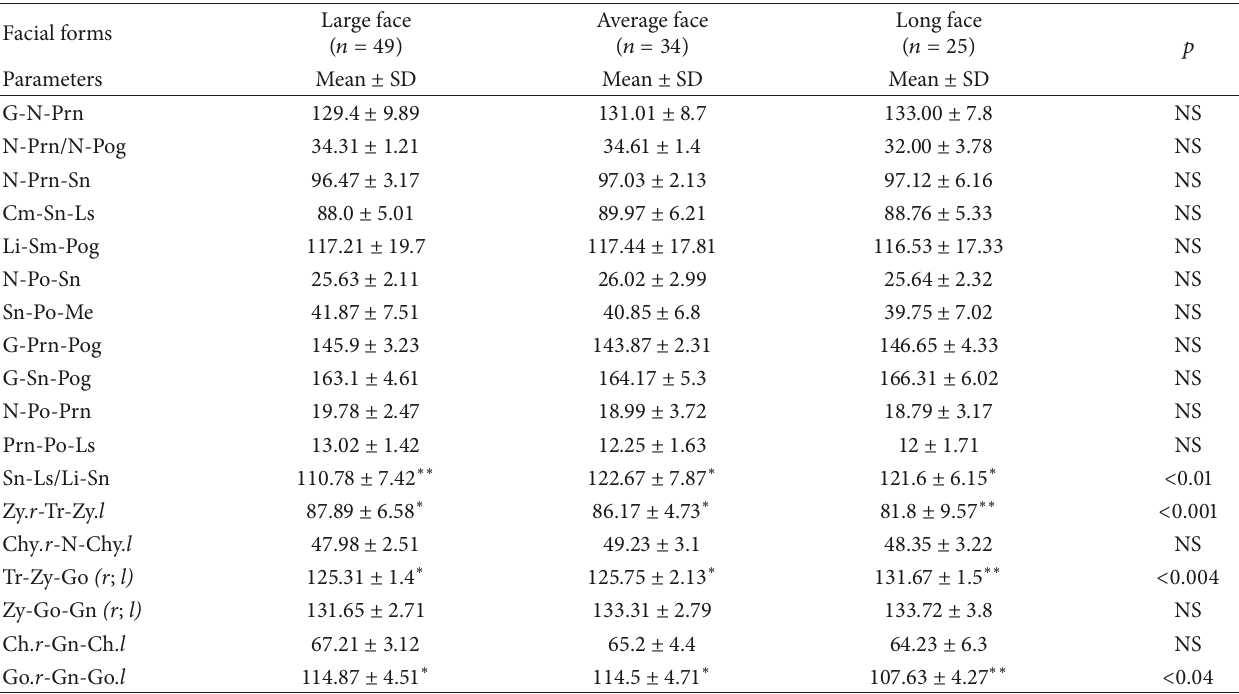
Table 5: Comparison of angular variables according to facial